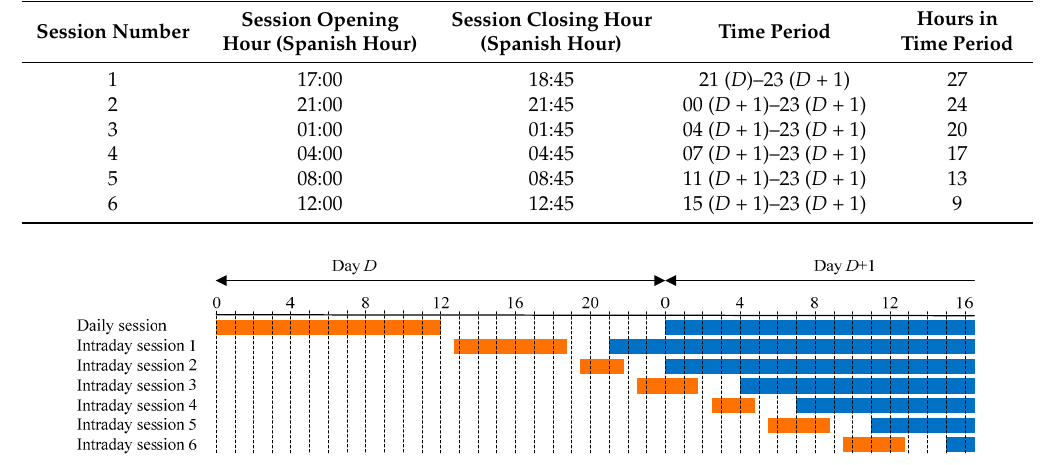
Figure 3. Time framework for outputs of intraday session models for price forecasts (ISMPF models).